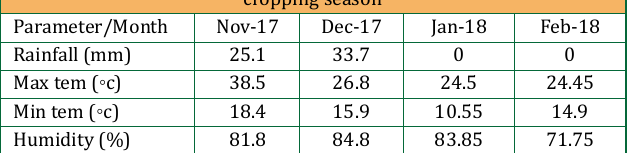
Table 1: Rainfall, maximum tem, minimum tem, humidity during